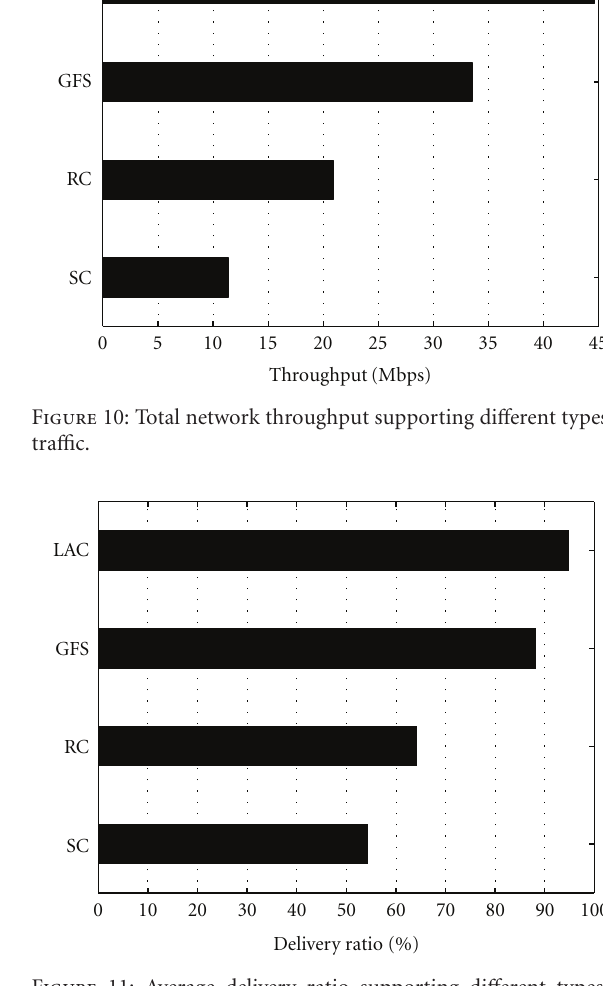
Figure 11: Average delivery ratio supporting di ff erent types of tra ffi